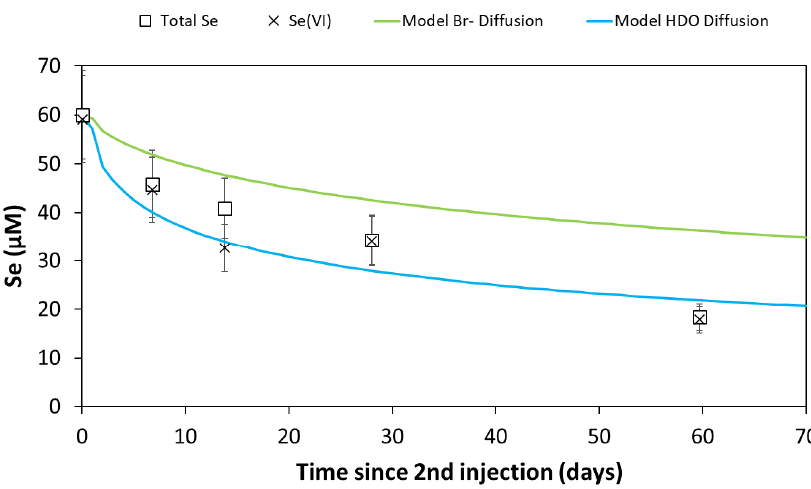
Figure 11. Measured concentrations (symbols) of Se(VI) and total Se in water samples after injection of the BN borehole with 60 µ M Se(VI) compared to the modeled diffusion of Se(VI), using the pore diffusion coefficients of either Br − (green line) or deuterated water (HDO; blue line) to represent the diffusion of Se(VI) anions. Note that only the time after the second injection with selenate is shown.